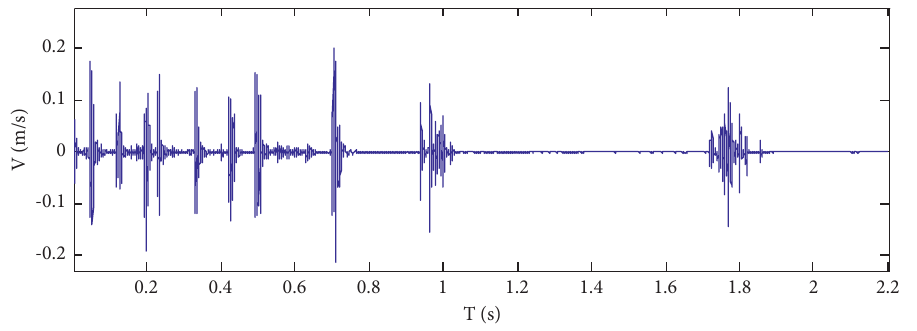
Figure 7: Waveform after HHT